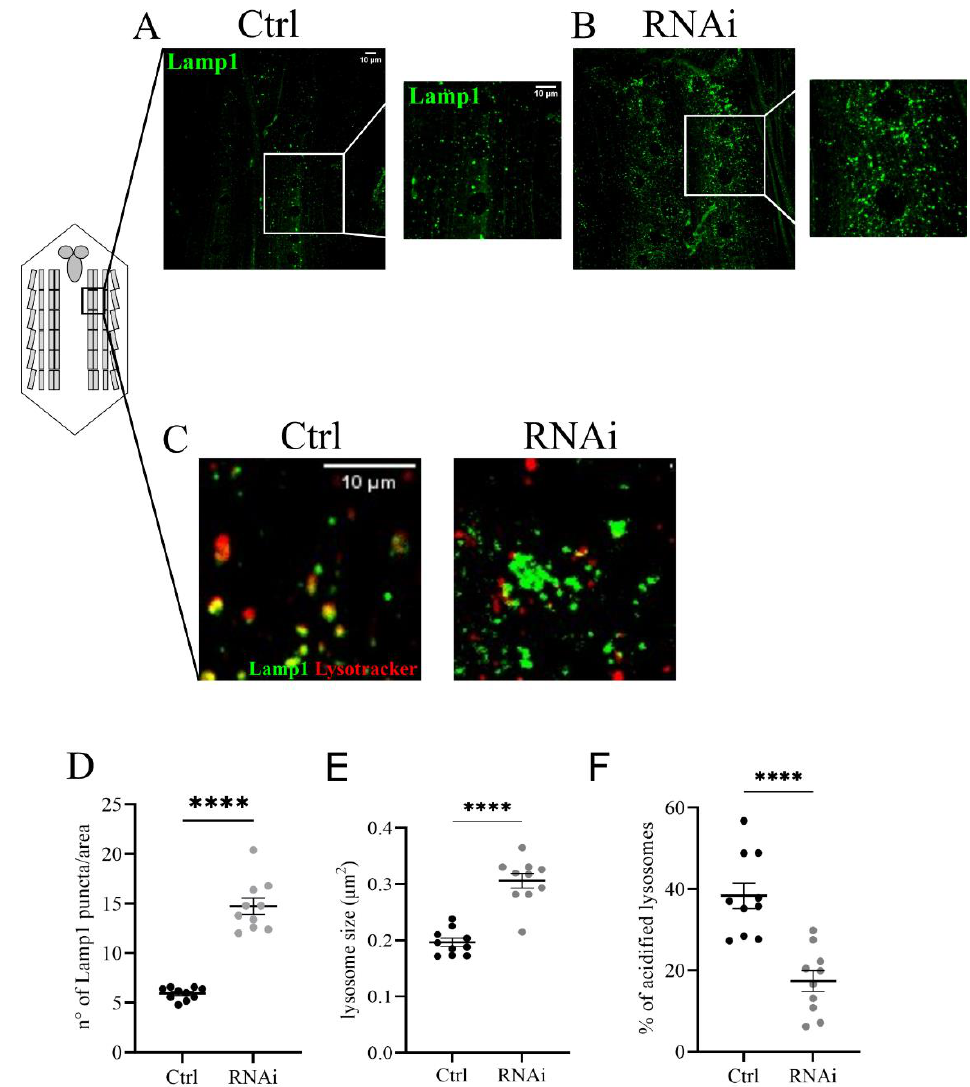
Figure 5. Lysosomal defects associated with a reduction of D-idua in muscles. Representative confocal images of muscles expressing the marker GFP-Lamp1 in ( A ) control and ( B ) RNAi III instar larvae and the relative quantification of the ( D ) number and ( E ) size of lysosomes. ( C ) Representative confocal images of III instar larvae muscles expressing the marker GFP-Lamp1 and stained with the probe Lysotracker red. ( F ) Quantification of correctly acidified lysosomes in the muscles of III instar larvae. n = 10 larvae/group. All data are expressed as means ± SEM. Asterisks indicate a statistically significant difference from the control (two-tailed Student’s t -test **** p < 0.0001). Genotypes of samples: Ctrl = Tubulin-Gal4; UAS GFP-Lamp1/+; RNAi = Tubulin-Gal4; UAS GFP-Lamp1/UAS D-idua RNAi3 . The number and size of lysosomes were automatically calculated with the software ImageJ in a ROI (area) of 350 µm 2 , as specified in the materials and methods section.